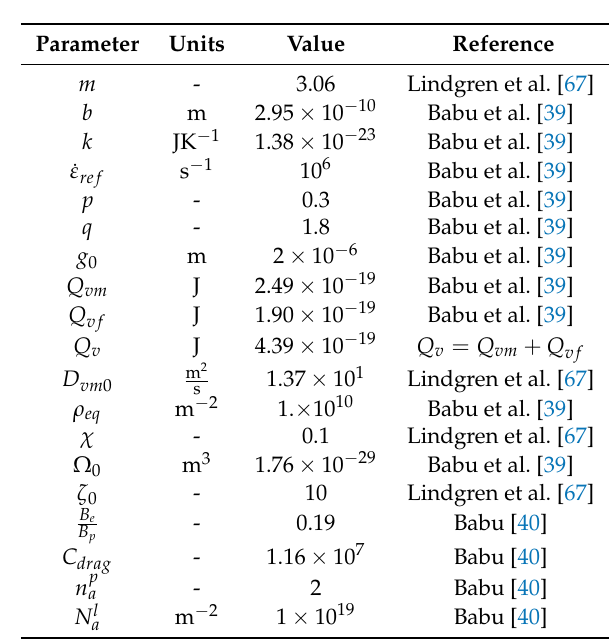
Table A1. Constant parameters of the dislocation density model.